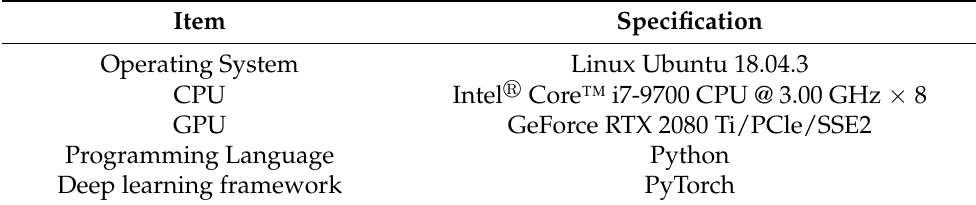
Table 1. The system information of experiment environment.